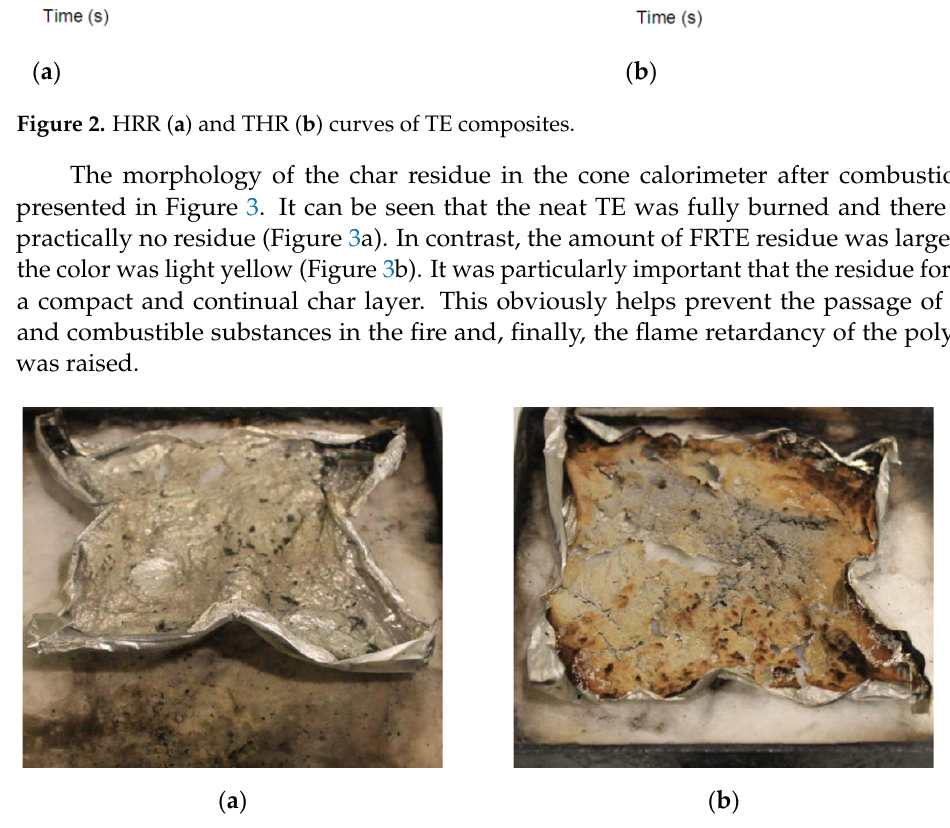
Figure 3. Residual char images of TE ( a ) and FRTE ( b ) after CONE measurement.